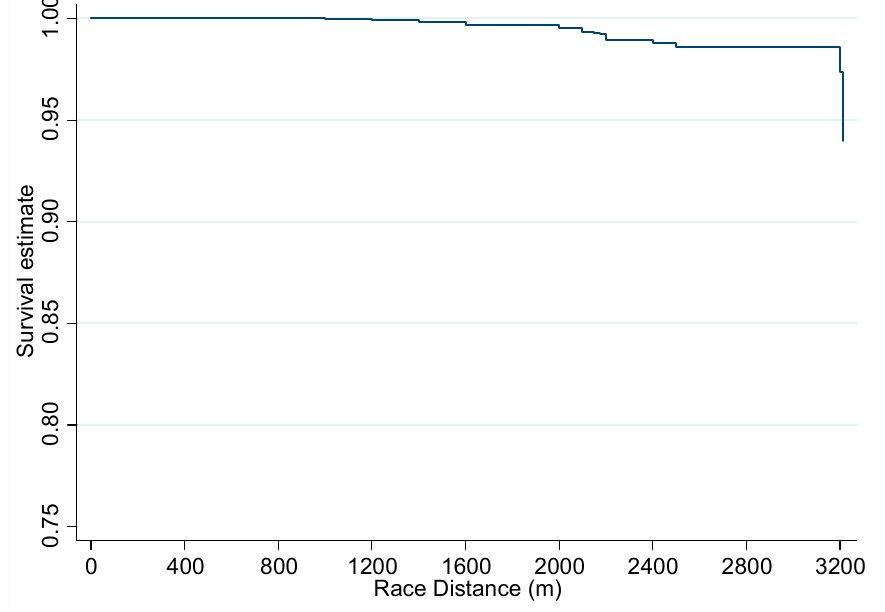
Figure 1. Kaplan-Meier survival curve for incidence of failure to finish and increasing race distance (m) for all Thoroughbred flat race starts in the 2005/06–2010/11 racing years in New Zealand (N = 188,615).